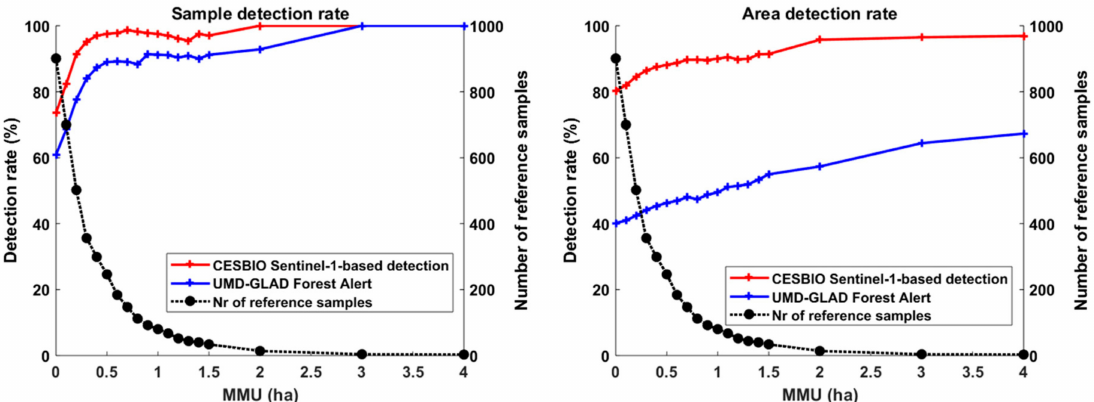
Figure 14. Overall sample ( left ) and area ( right ) detection rate of both approaches with respect to the minimum mapping unit (MMU) of the reference